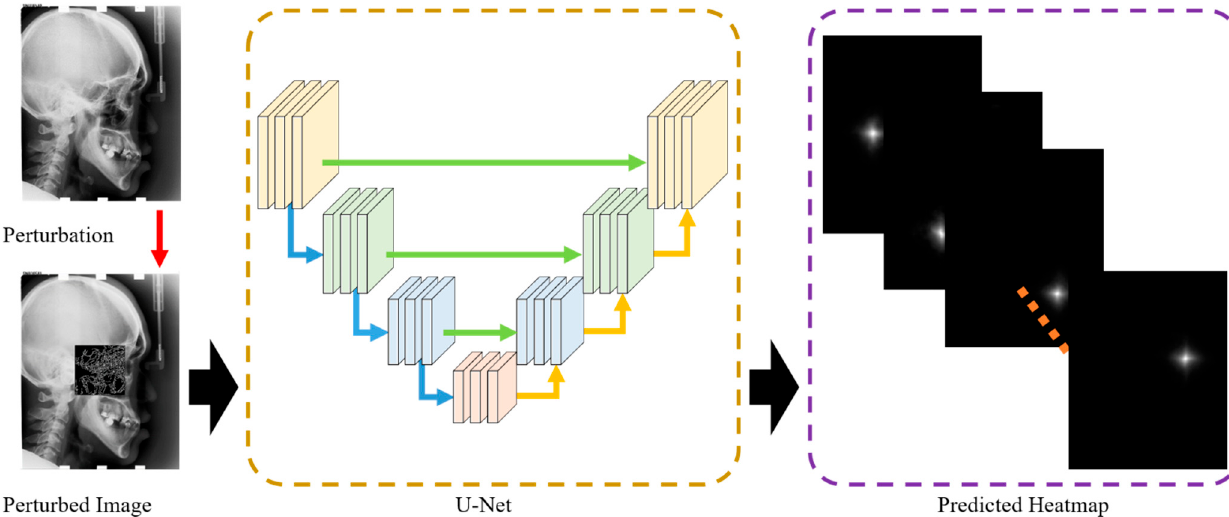
Figure 1. Overall framework of the proposed model. Left side: original image is perturbed before entering the U-Net, Right side: label images where each image represents a landmark.